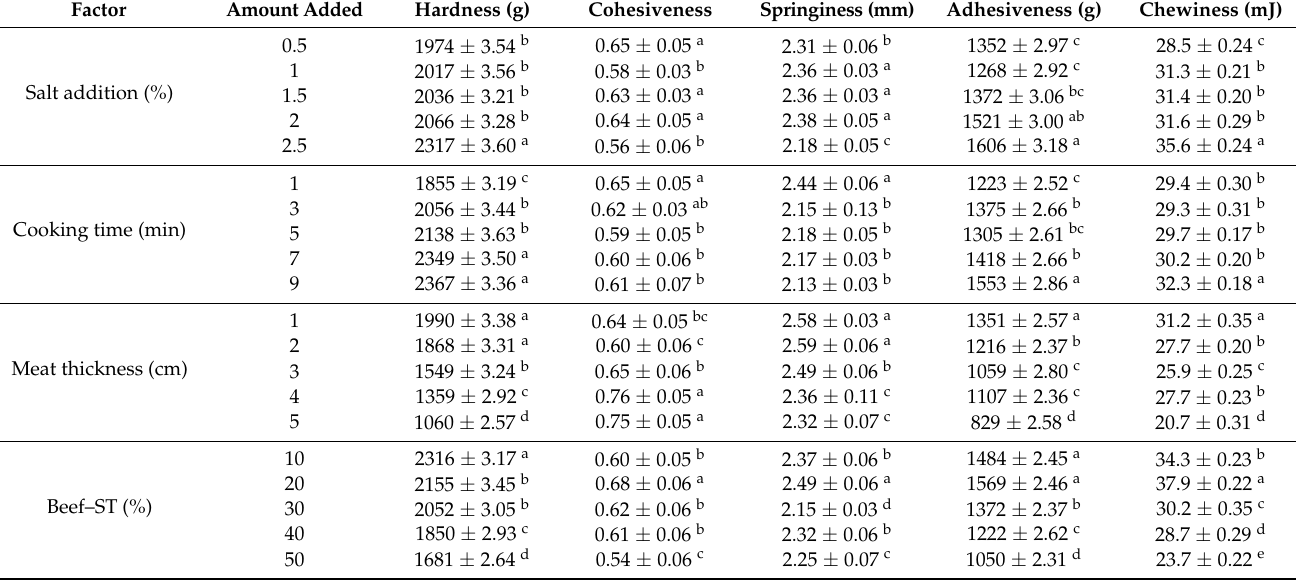
Table 2. Effect of each factor on texture.